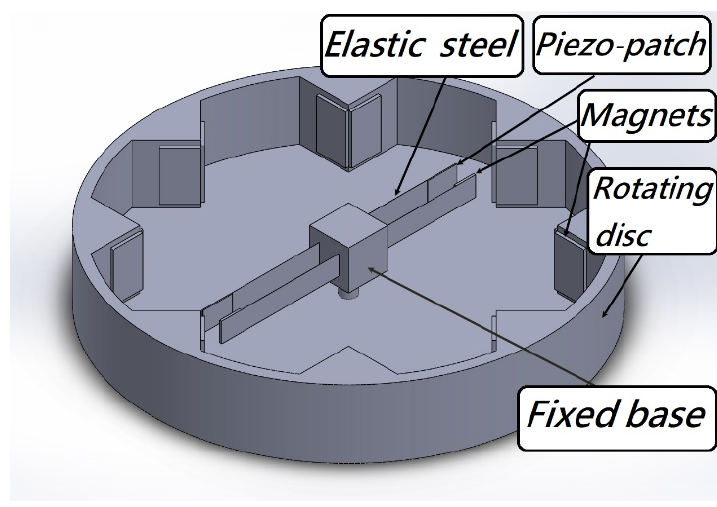
Figure 1. 3D schematic diagram of the theoretical model. The theoretical CVEH system is shown in Figure 3, one of which is a fixed-free beam with a tip mass (magnet), and the other is a fixed-free beam with a PZT patch. The CVEH system proposed in this study directly exerts force ( F TP ) on the piezoelectric device through the effect of slapping, which will enable this design to break through the current bottleneck of energy conversion in the vibration energy harvesting system, and exert a greater function of the VEH